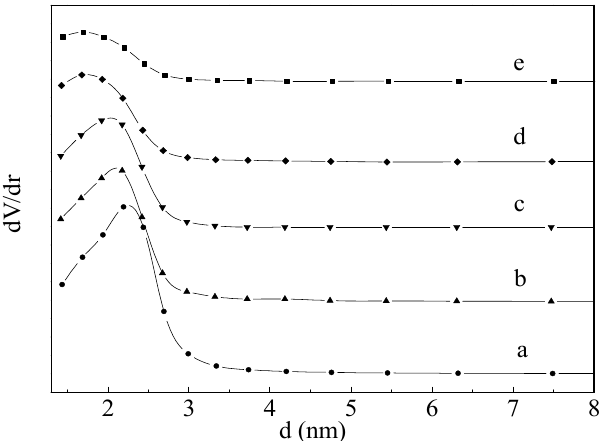
Figure 2. Pore diameter distribution of MSU-1 and VO x /MSU-1 with different VO x loading. ( a ) MSU-1; ( b ) 2.5 wt. % VO x /MSU-1; ( c ) 7.0 wt. % VO x /MSU-1; ( d ) 12.0 wt. % VO x /MSU-1; and ( e ) 17.5 VO x /MSU-1.